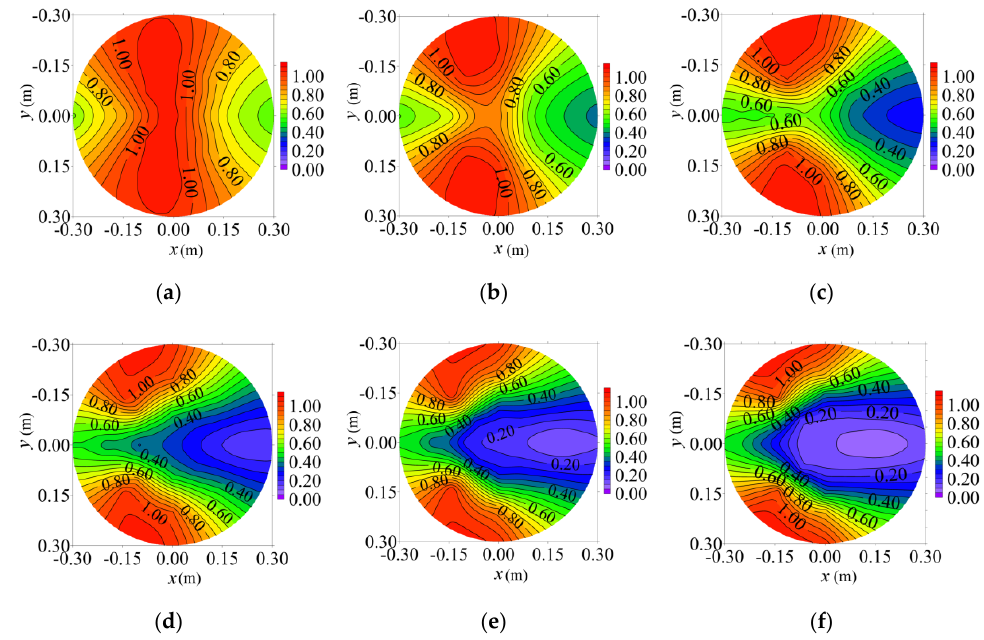
Figure 10. Contour maps of M t,ma x for horizontal wind velocity ( L = 0.5 D jet , r h = 1.0 D jet ): ( a ) H / h = 1/12; ( b ) H / h = 1/6; ( c ) H / h = 1/4; ( d ) H / h = 1/3; ( e ) H / h = 5/12; ( f ) H / h = 1/2.